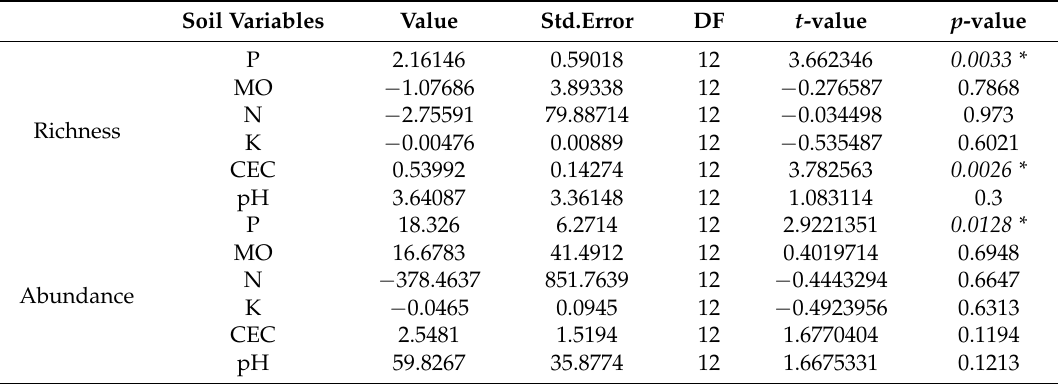
Figure 2. ( a ) The average density of individuals in each quarry and target vegetation. ( b ) Distribution in diametric classes of quarries ( n = 438) and target vegetation ( n = 706). Table 5. The results of the linear mixed model (LMM), relating species richness and abundance with soil variables ( * = p < 0.05